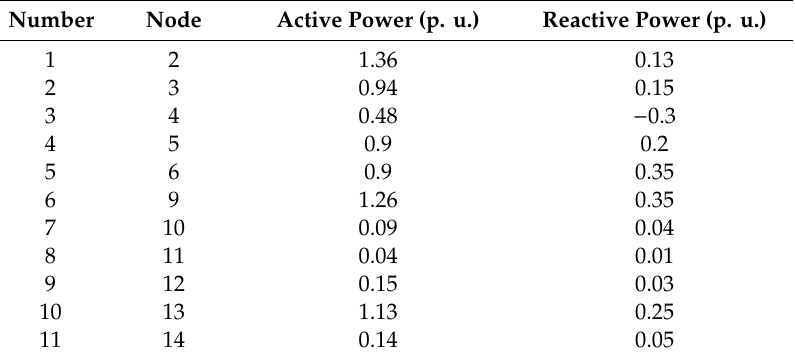
Table 4. Load parameters.